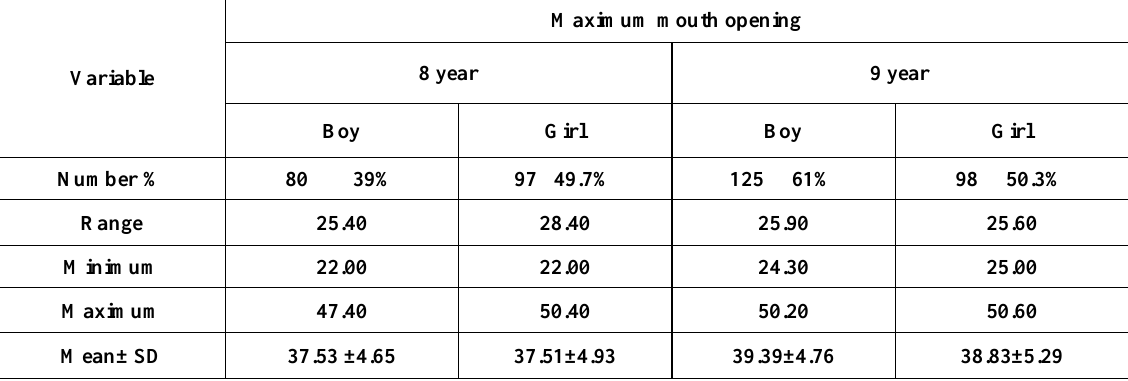
Table (1): Distribution of the study sample according to age and gender in relation to the maximum mouth